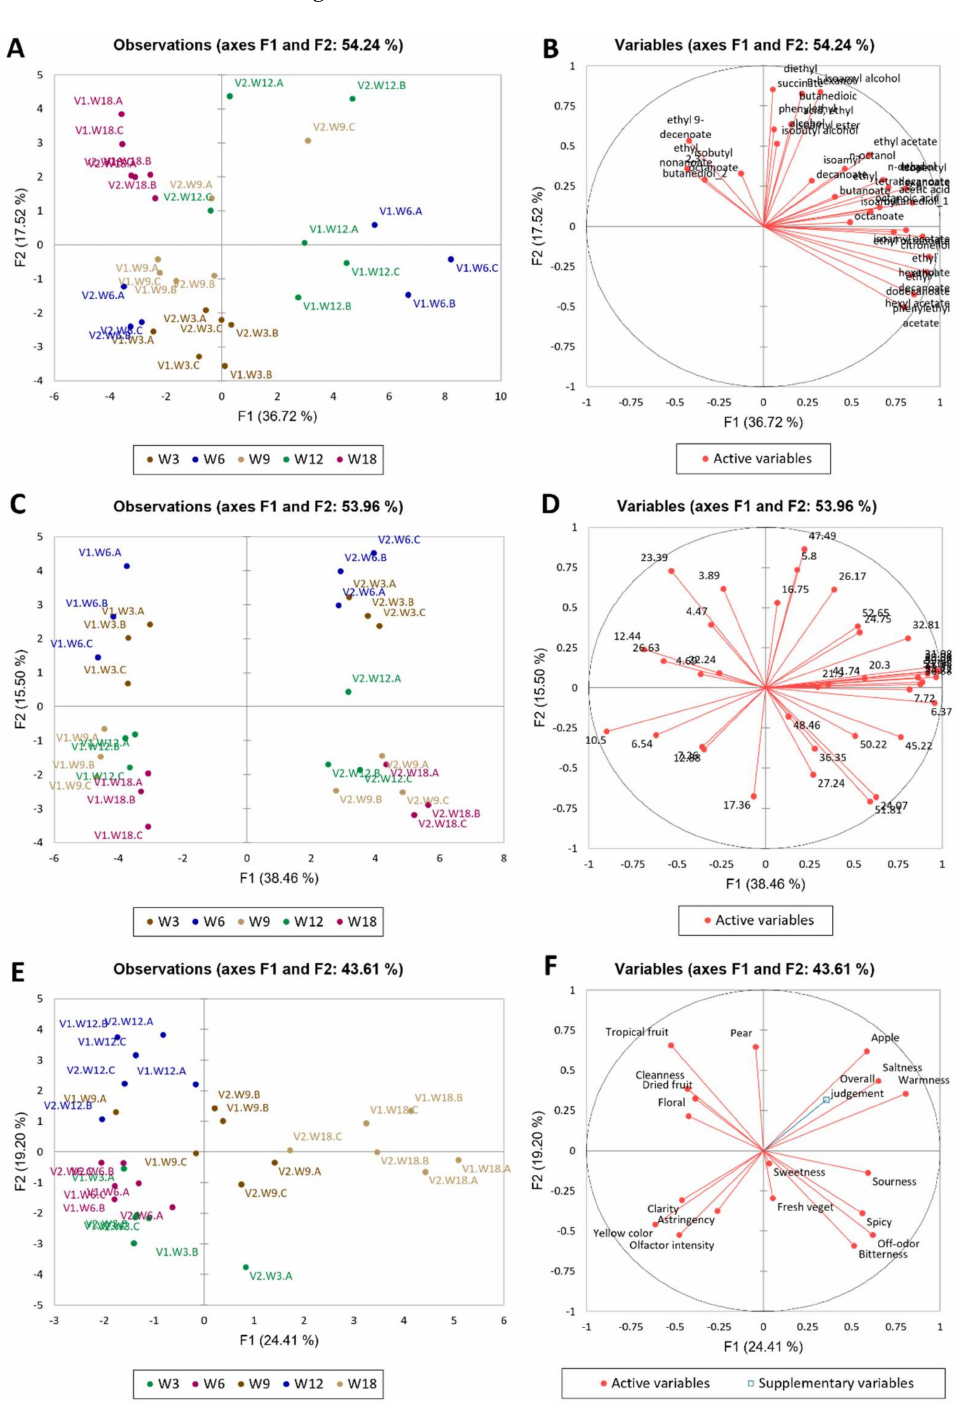
Figure 1. Principal component analysis for the GC-MS data (( A ) observation plot and ( B ) variables plot), HPLC data (( C ) observation plot and ( D ) variables plot), and sensory data ( E ) observation plot and ( F ) variables plot). W: wine; 3, 6, 9, 12,18: months of storage in bottle; V1: control vinification, V2: experimental vinification. Overall quality judgment was used as a supplementary (non-active) variable in the